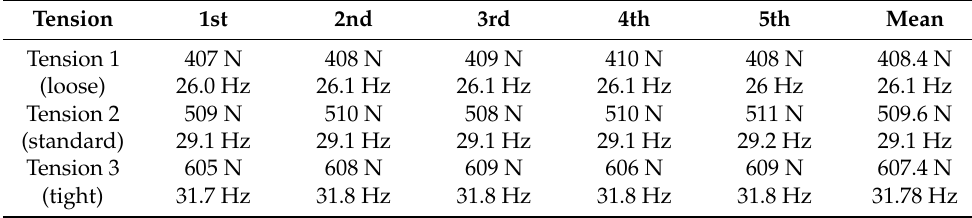
Table 4. Results of belt tension measured using a sonic tension